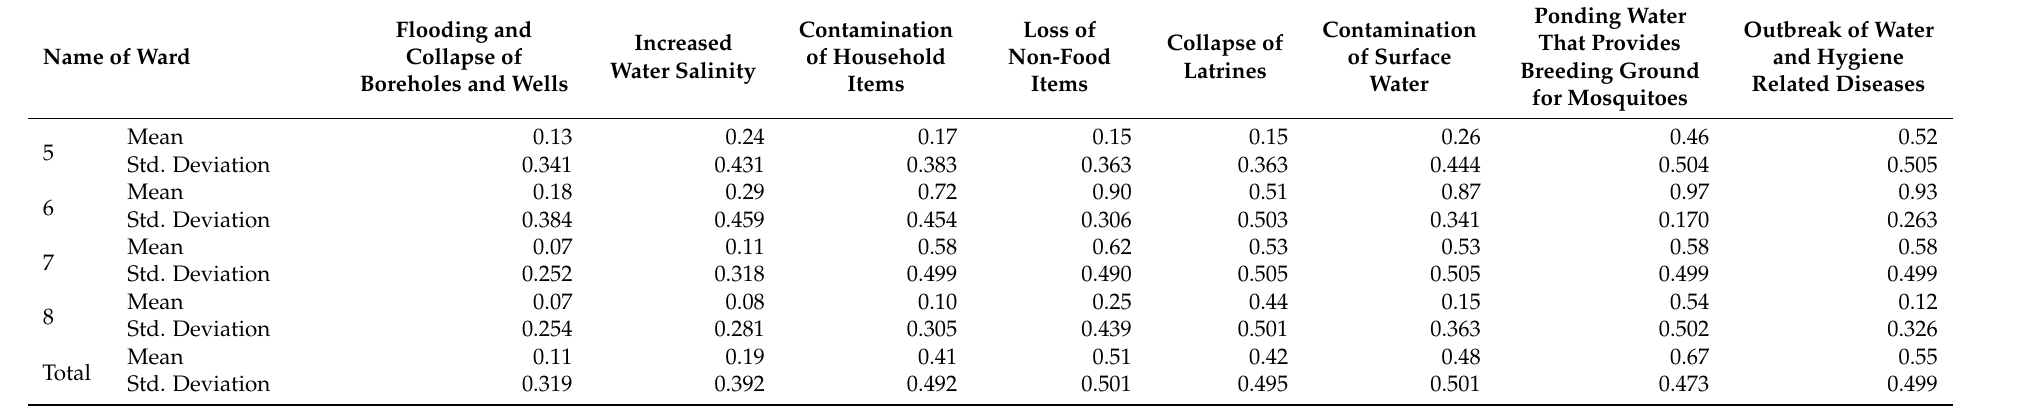
Table 1. WASH problems experienced during flood episodes in Tsholotsho